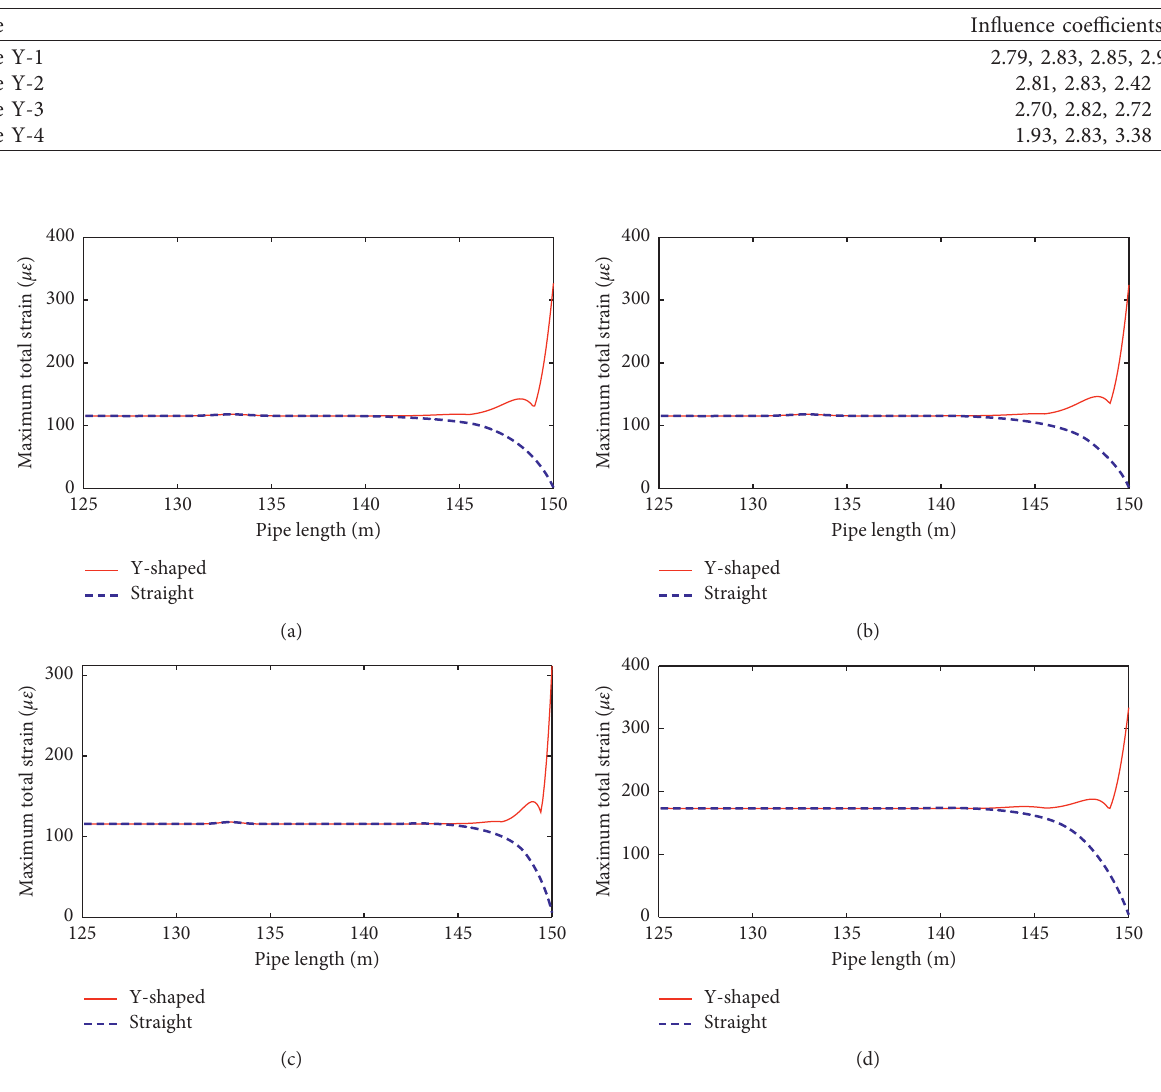
Figure 29: Maximum strain of Y-shaped connection under different parameters: (a) Case Y-1, site class II; (b) Case Y-2, 30 ° branch angle; (c) Case Y-3, 0.2191m pipe diameter; (d) Case Y-4, 30 ° incident